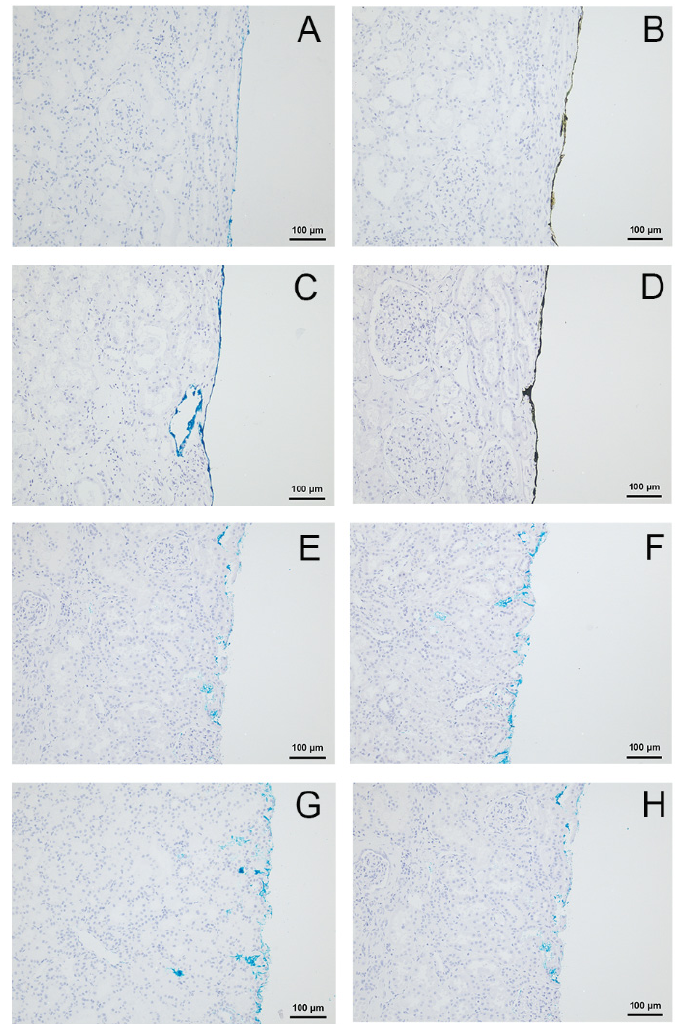
Figure 1. Colour change of tissue marking dye (TMD) from provider A during immunohistochemistry was not observed with Dako K5005 ( A ) but with Dako K8002 containing 3,3 ′ -Diaminobenzidine-tetrahydrochloride-dihydrate (DAB) ( B ). No colour change of TMD from provider A by treatment with Kit A ( C ) but by treatment with Kit B ( D ) containing DAB. The marking dyes from provider B ( E , F ) and provider C ( G , H ) remained unchanged with Dako K5005 ( E , G ) as well as with Dako K8002 ( F , H ).